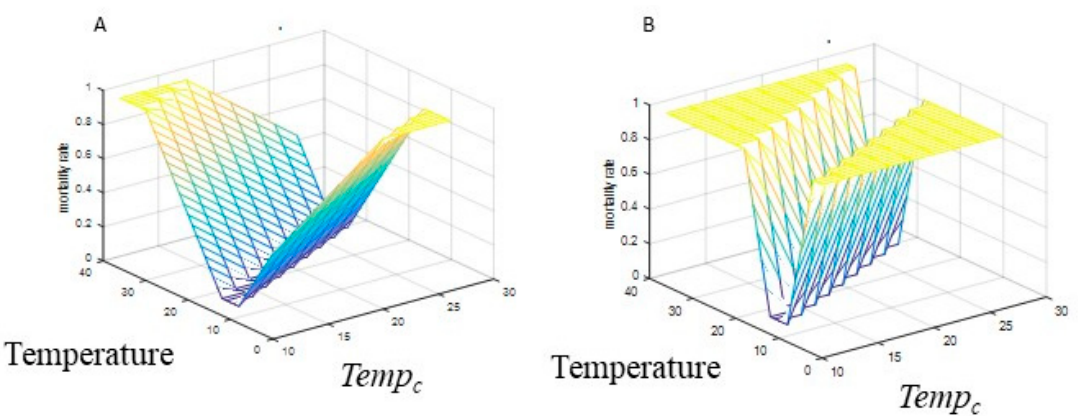
Figure 2. Mortality functions. ( A ) µ sl = 0.05; ( B ) µ sl = 0.15.